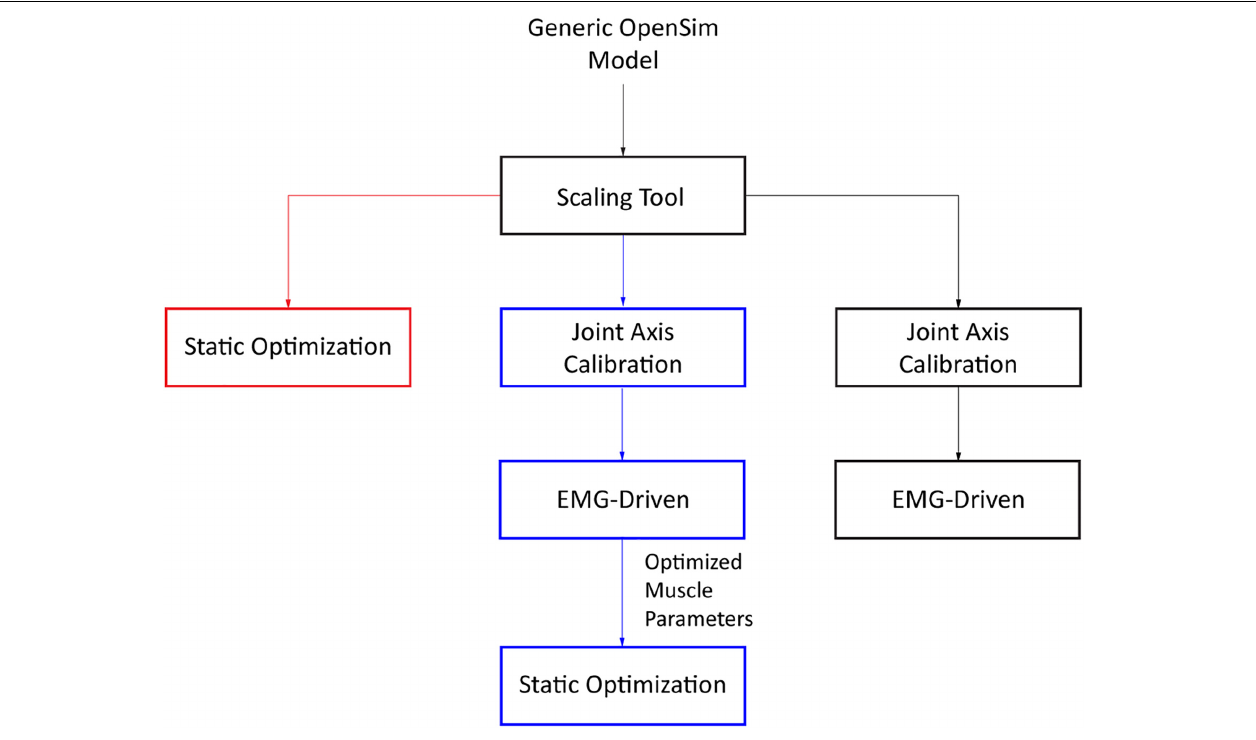
FIGURE 1 | Flowchart of the three different approaches used to obtain estimates of muscle activations (SOGen: red, SOCal: blue, EMGCal: black). TABLE 3 | Analysis of covariance p -values comparing slopes of CoT versus walking speed, step length asymmetry, stance time asymmetry, and double support time asymmetry regression lines between the nine model predictions and experimental measurements from Finley and Bastian (2017). Umberger et al., 2003 Umberger, 2010 Bhargava et al., 2004 SOGen SOCal EMGCal SOGen SOCal EMGCal SOGen SOCal